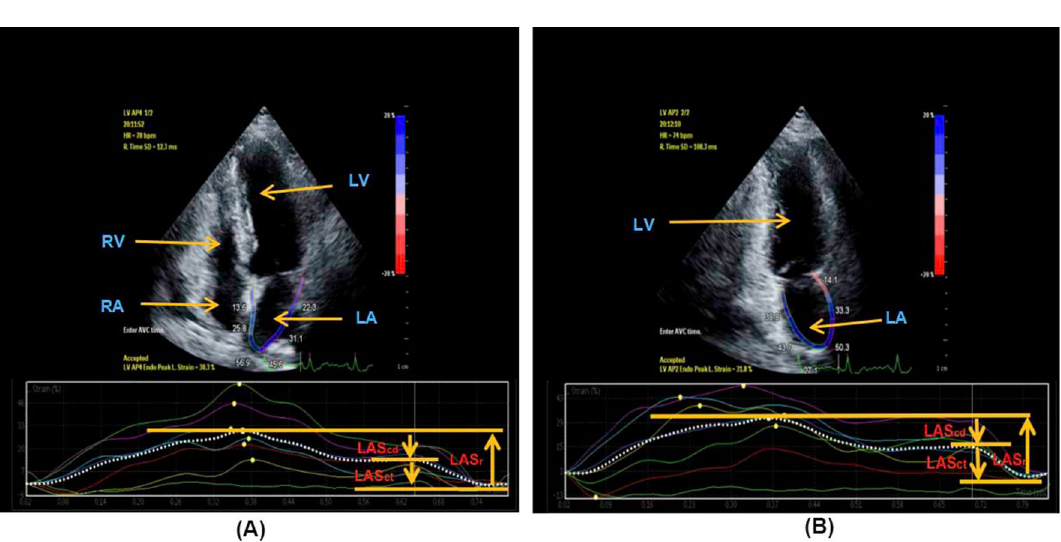
Figure 2. 2D-STI parameters of left atrium in Group I. 2D-STI parameters of left atrium obtained from apical four-chamber view in Group I ( A ). 2D-STI parameters of left atrium obtained from apical two-chamber view in Group I ( B ). LAGLS left atrial global longitudinal strain, LASr left atrial strain during reservoir phase, LAScd left atrial strain during conduit phase, LASct left atrial strain during contraction phase, LV left ventricle, LA left atrium, RV right ventricle, RA right